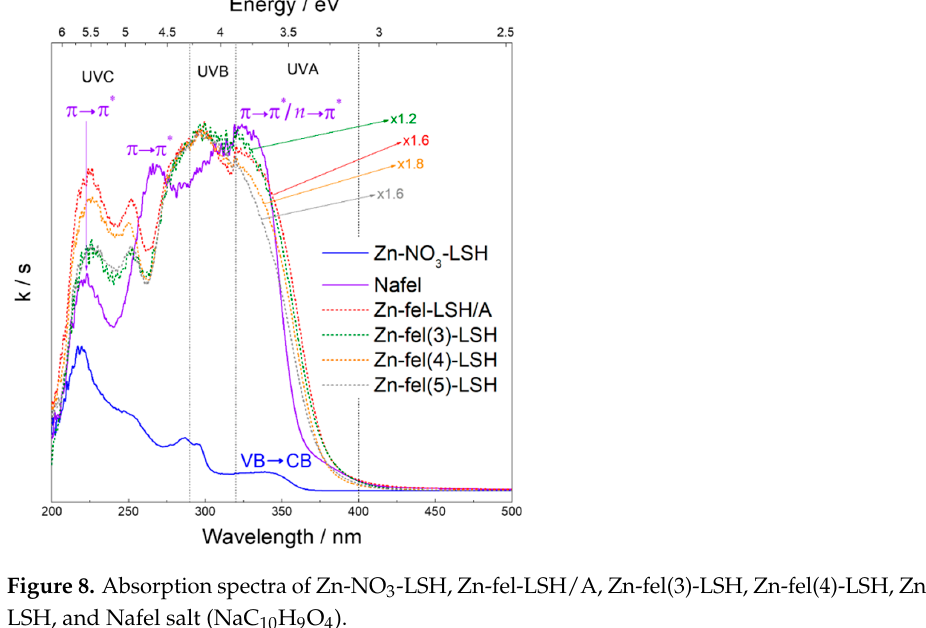
10 of 30 Figure 7. ( a ) Brightness scale; ( b ) Color scale corresponding to the CIELab color diagram of Zn-NO 3 -LSH matrix, Nafel salt (NaC 10 H 9 O 4 ), and LSH-ferulate materials. The absorption spectrum of the Zn-NO 3 -LSH matrix (Figure 8) shows broad bands with maximum values at 220, 251, 287, and 296 nm, which are assigned to electronic transi- tions of the nitrate anions intercalated [47,48]. This spectrum also exhibits an absorption